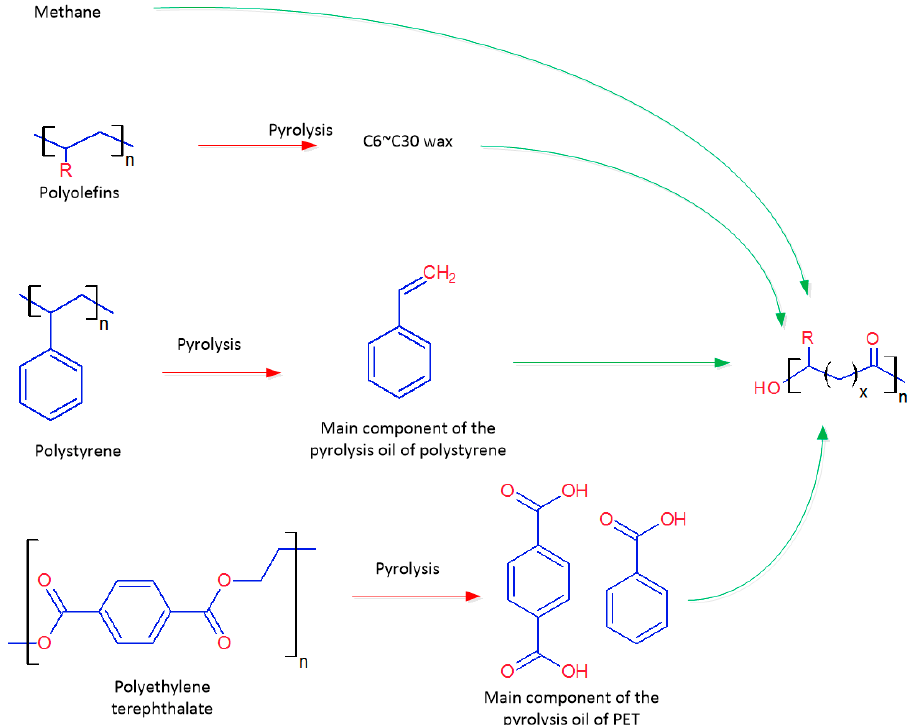
Figure 5. Hydrocarbons as substrates for PHA production and their derivation processes. Red and green arrows indicate chemical and biological processes respectively.